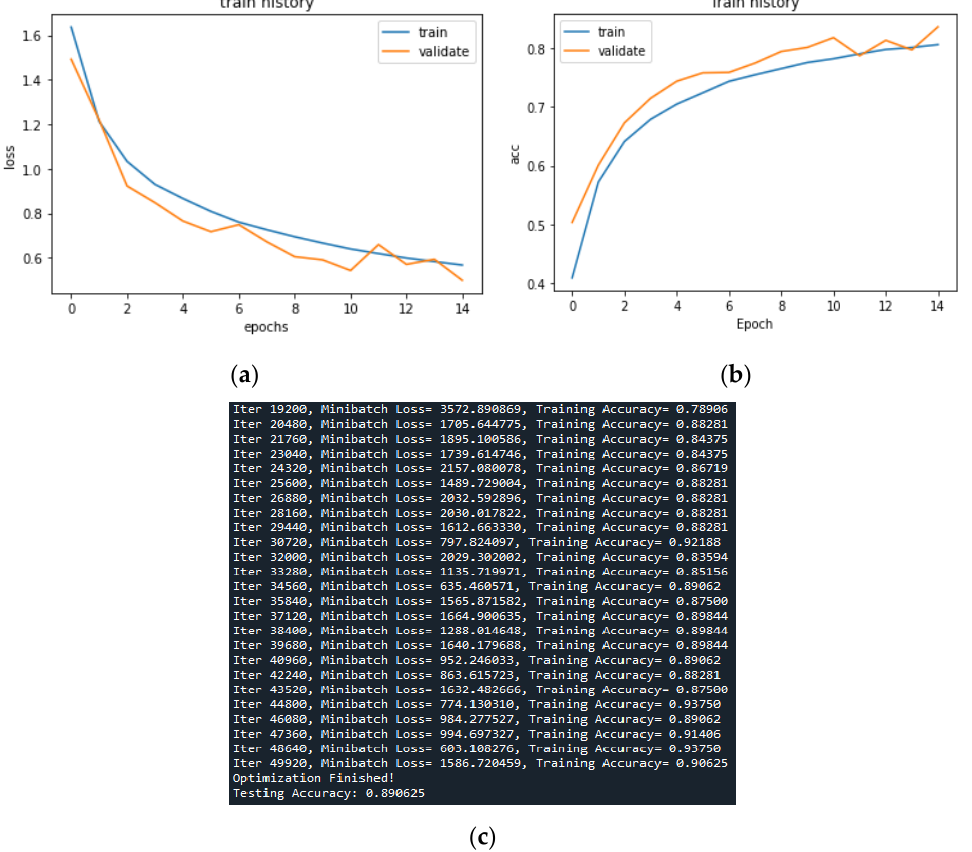
Figure 15. ( a ) Error training history. ( b ) Accuracy training history. ( c ) The fluctuation of parameters.